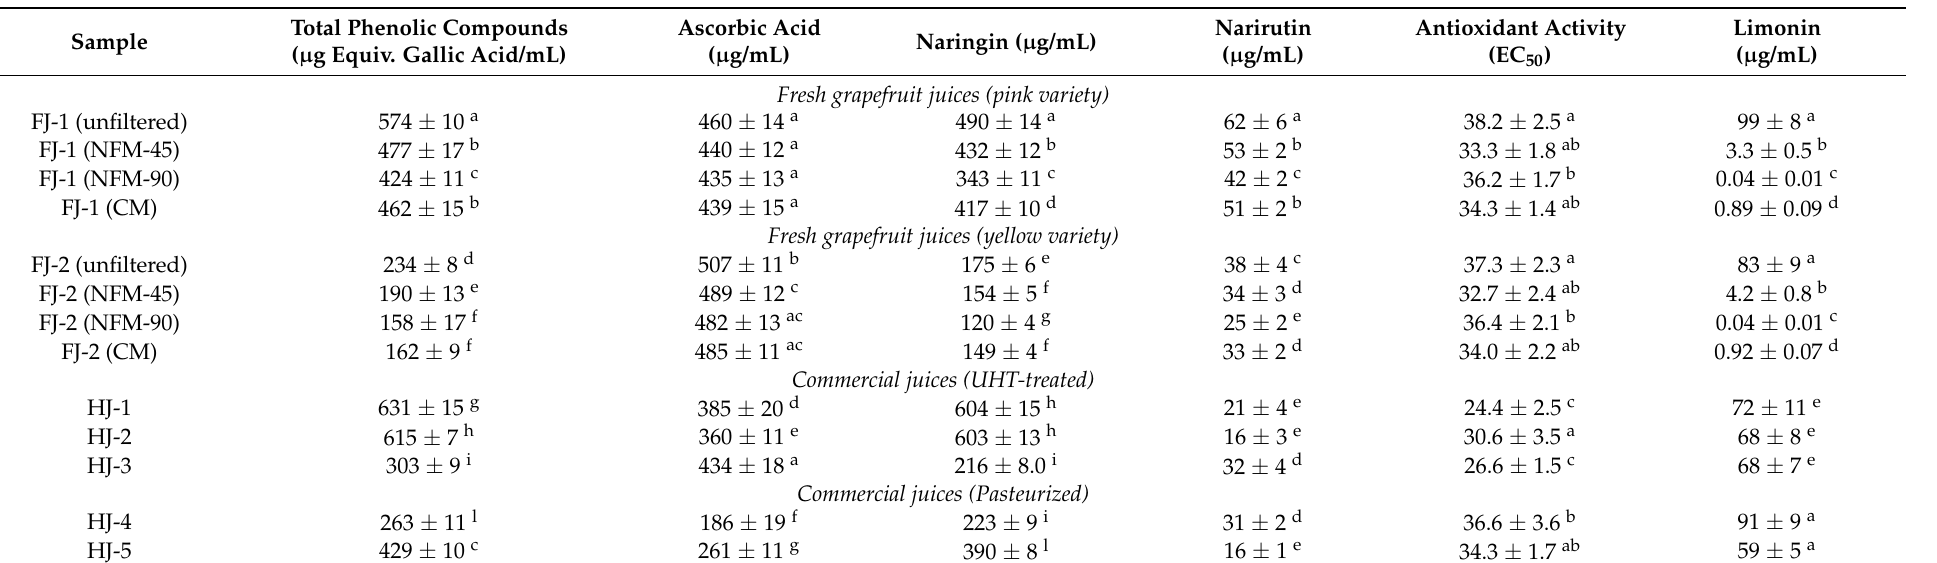
Table 2. The concentration of total phenolic compounds, ascorbic acid, naringin, narirutin, and limonin, and an in vitro antioxidant activity (DPPH radical scavenging capacity) of two varieties of grapefruit juices, their filtrates obtained using nylon-6 nanofibrous membranes of different thickness (NFM-45, NFM-90),